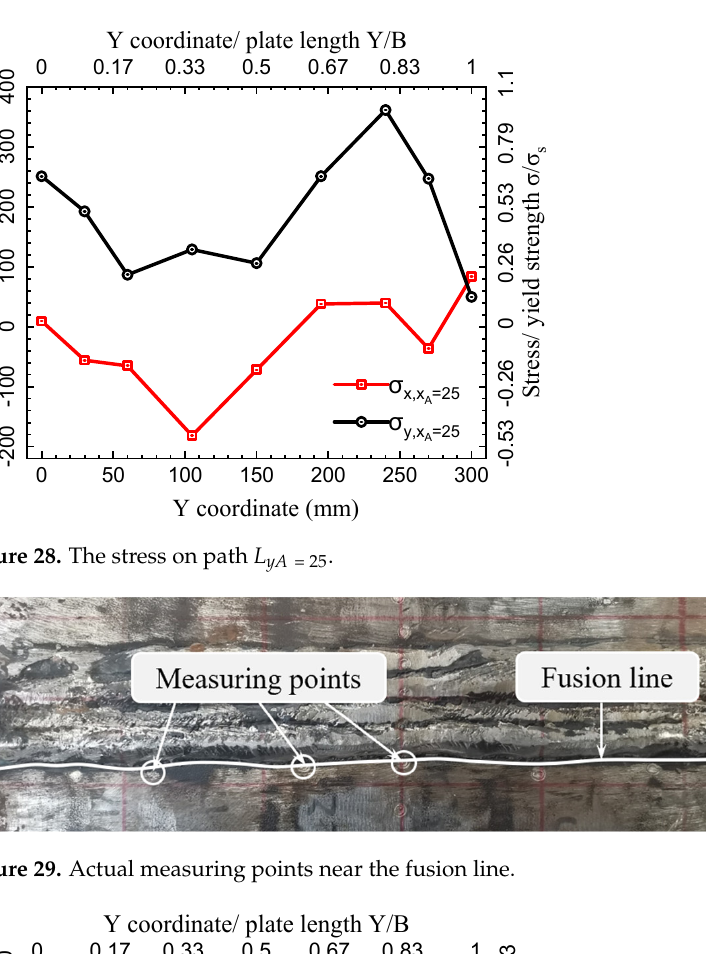
Figure 29. Actual measuring points near the fusion line.